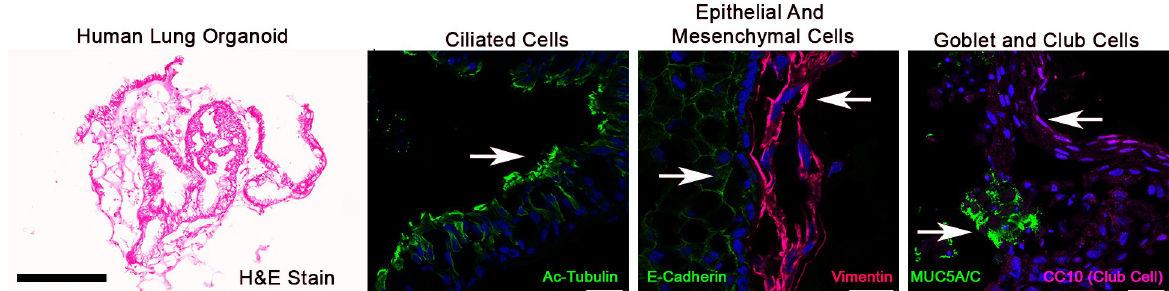
Fig 1. Human lung organoids (HLOs). The HLOs used in this study replicated the 3-dimensional architecture and cell composition of human fetal lungs such as ciliated cell, mesenchymal cells, goblet and club cells. The HLO shown in the left panel was 50 days old. Scale bar left panel 300 μ m, scale bars in the right three panels are 25 μ